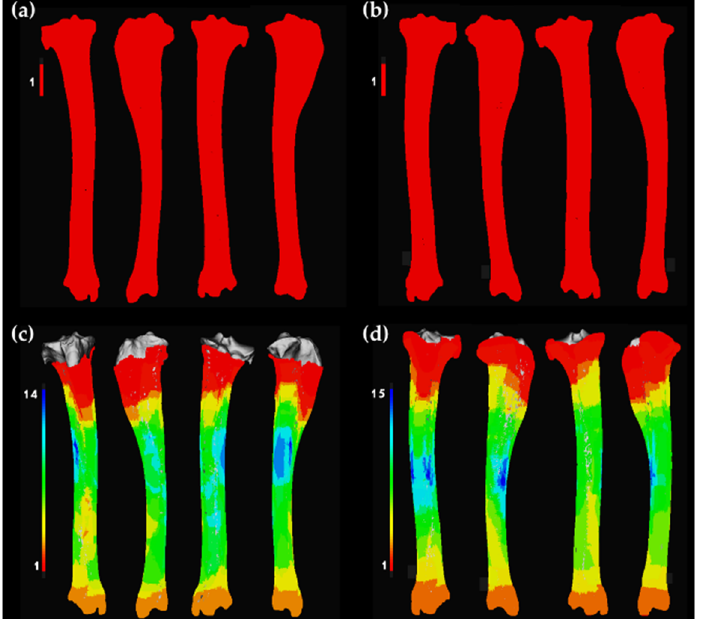
Figure 3. Heatmaps generated in Ikhnos . Bone preservation for right and left tibiae modified by wolf populations divided by ( a ) right tibiae modified by wild wolves; ( b ) left tibiae modified by wild wolves; ( c ) right tibiae modified by captive wolves; ( d ) left tibiae modified by captive wolves. Red-shaded portions indicate areas of lowest survivorship, whereas blue-shaded portions indicate areas of highest survivorship, namely the MNE. In the case of the wild wolf populations, the highest and lowest survivorship is the same.